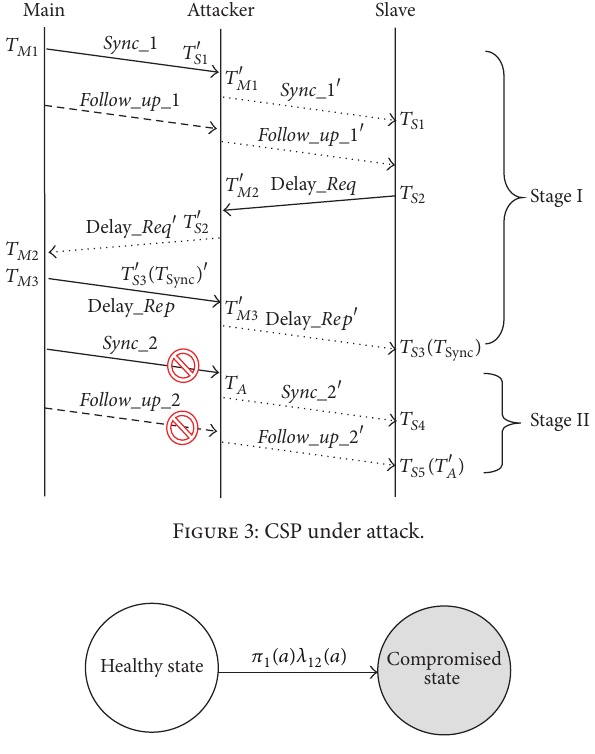
Figure 4: A two-state stochastic process with security failure rate assigned.